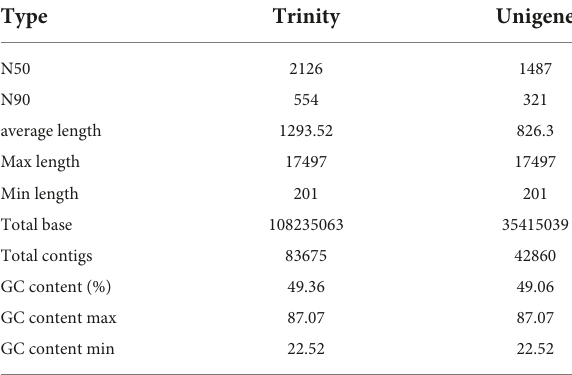
TABLE 1 Data statistics of the transcriptome sequencing in R solani AG-3 TB